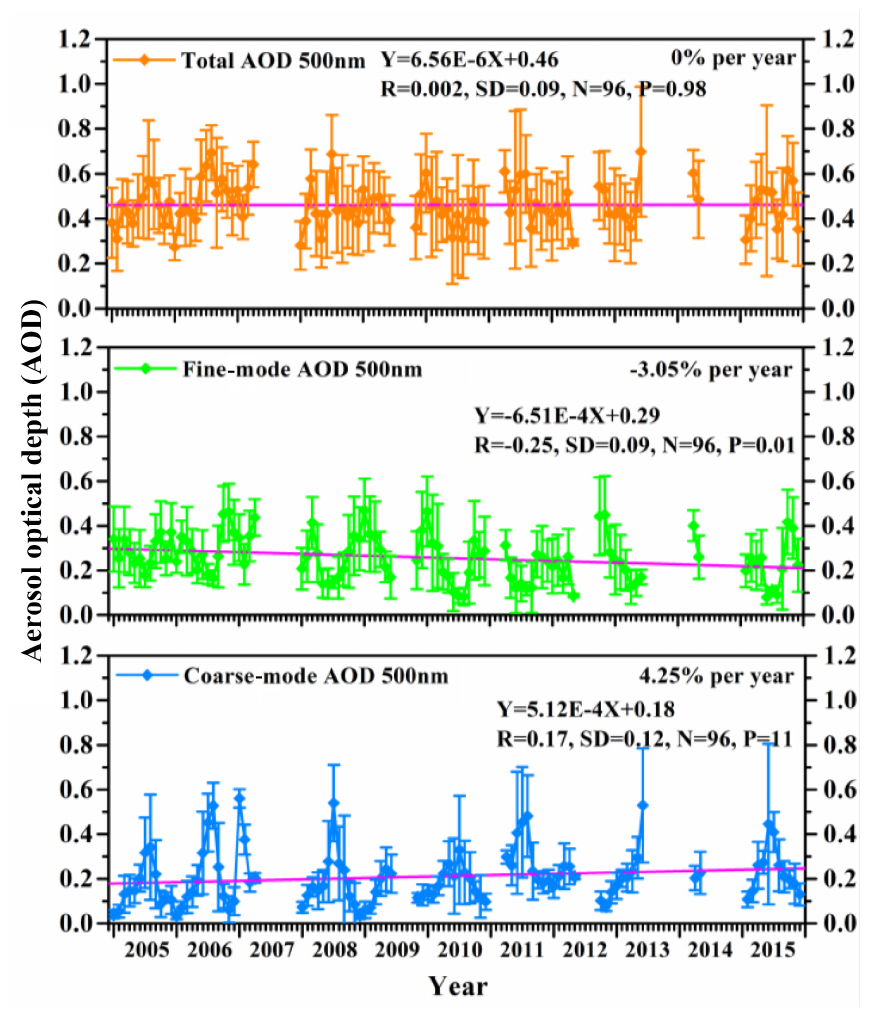
Figure 13. Year-to-year variation in total, fine-mode and coarse-mode AOD during 2005–2015. The solid red lines passing through the data represent respective long-term trends. The vertical bar at each data point represents the standard deviation from the